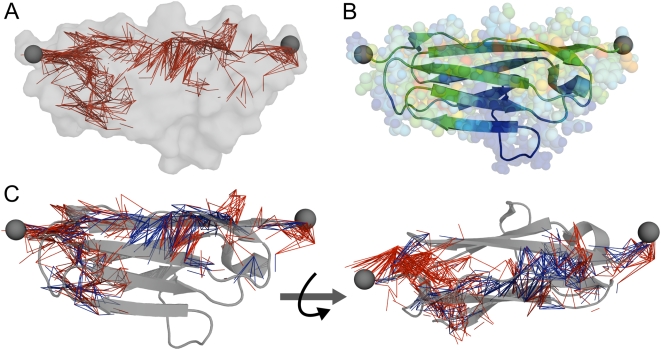
Force distribution in I27.(A) Graph representation of changes in interatomic forces, , observed upon mechanical perturbation of I27. Edges connect non-bonded atom pairs with . The protein surface is shown in gray. A 3D animation of this figure is available as Video S1. (B) Changes in atomic forces, Δf, mapped onto the protein structure. Colors range from blue for elements outside the mechanical network with Δf = 0 to red for force bearing elements with high Δf. (C) Graph representation of  displayed as edges as in (A). I27 is shown as cartoon. Edges connecting main-chain atoms are colored blue, those connecting side chain atoms are colored red. Mechanical load at the C-terminus is mainly taken up by main-chain interactions around the A'G strand, whereas at the N-terminal side forces are primarily propagating into the protein core by side chain interactions.